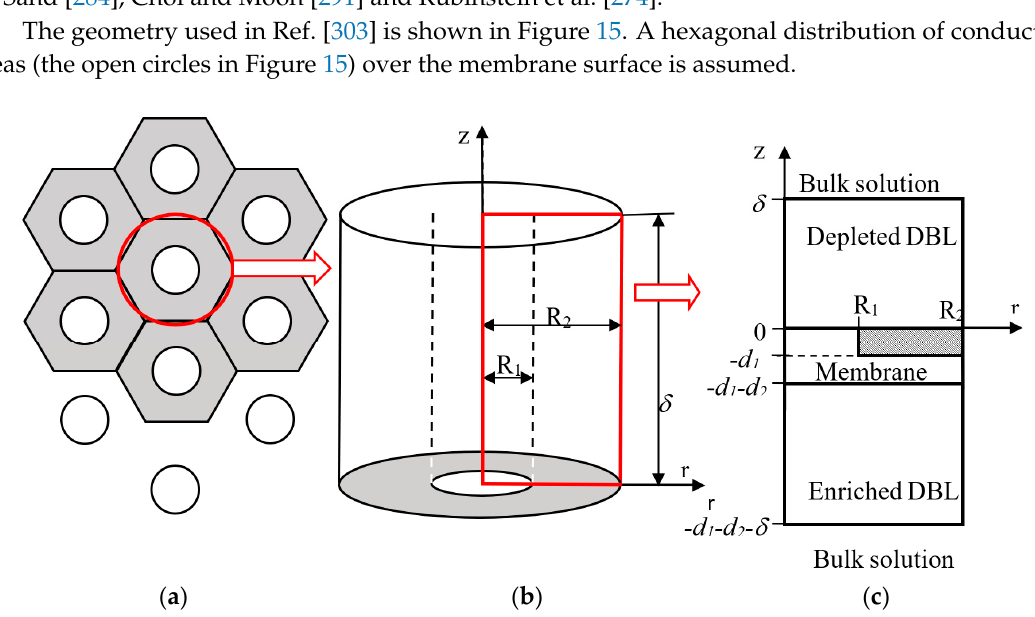
Figure 15. Distribution of round conductive areas over the membrane surface in hexagonal geometry ( a ). The DBL of thickness δ is assumed independent of lateral position ( b ). Conversion of the 3D system ( b ) into a 2D simulation problem ( c ). Reproduced with permission from [303], American Chemical Society, 2016.